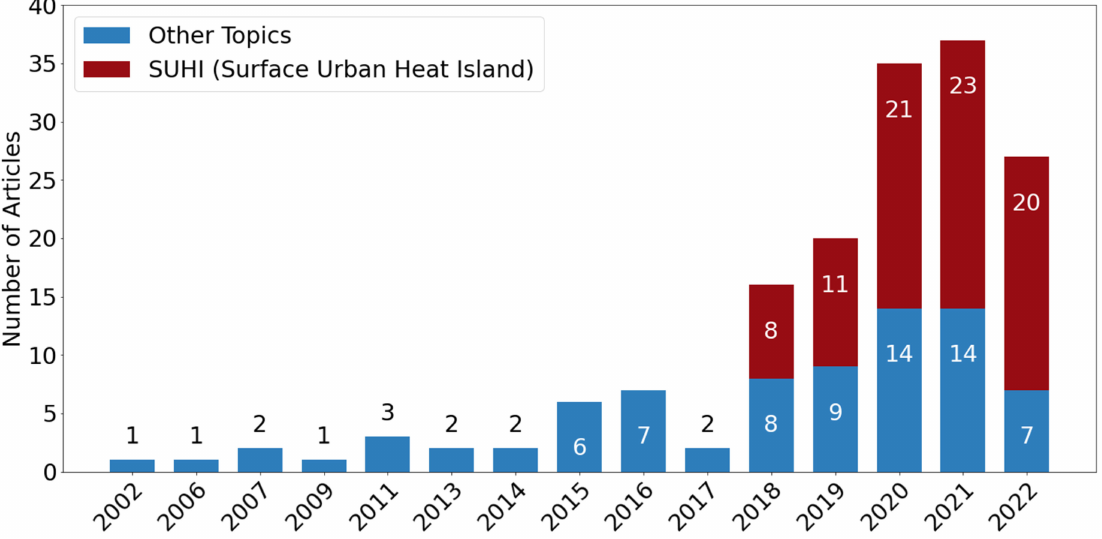
Figure 4. Number of reviewed studies per year. The number in 2022 is smaller because only studies published before August 2022 were